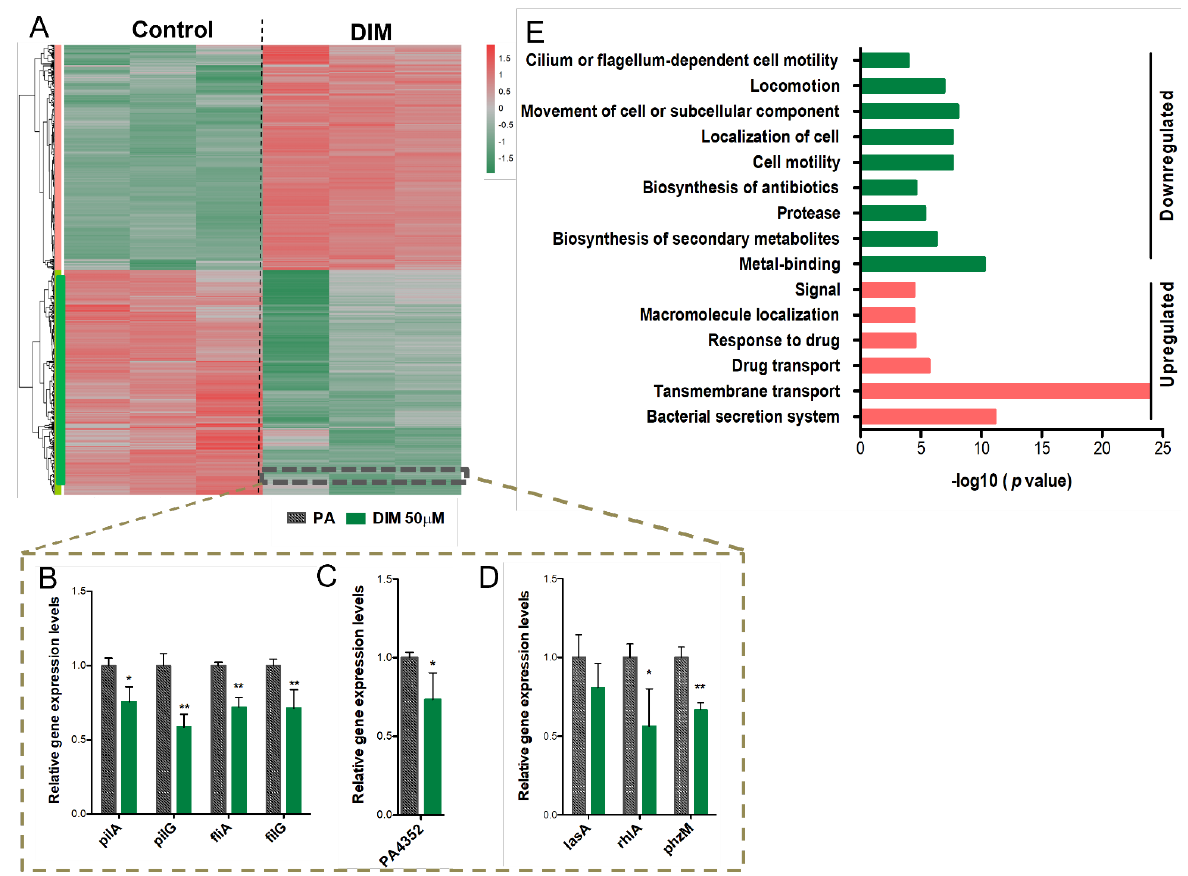
Figure 3. Heterogeneity in gene expression of P. aeruginosa PA01 in response to 50 µM DIM. Hier- archical clustering and heat map of RNA-seq data ( A ). Counts were normalized with DeSeq2 and then transformed via log 2 prior to clustering and visualization. Genes were considered differentially expressed if they had FDR-adjusted p -value < 0.05 and absolute fold change (in linear scale) ≥ 1.3. Downregulation of a gene is indicated in green, and upregulation is indicated in red. The dashed box denotes genes whose expression was further verified by RT − PCT: motility − associated genes ( B ), stress response gene ( C ), and virulence encoding factors ( D ). The relative magnitude of gene expression level was defined as the copy number of cDNA of each gene normalized by the copy number of cDNA of the housekeeping gene, proC. Error bars indicate the SD of at least three measure- ments. ** p < 0.005 vs the control. * p < 0.05 vs control. Genes that were differentially expressed (log 2fold change (FC) ≥ 1.3) in the transcriptional profile were assigned to David’s functional annotation chart (combined heterogeneous annotations). The enrichment of functional categories representing both downregulated pathways (green) and upregulated ones (red) ( E ). Categories with significantly enriched genes are depicted as FDR < 0.05 and p -value ≤ 0.05, while log10 ( p -value) is indicated at the